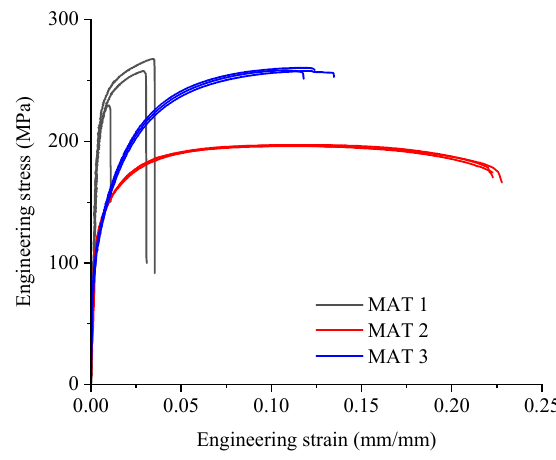
Figure 3. Engineering stress vs. strain curves of the three alloys.